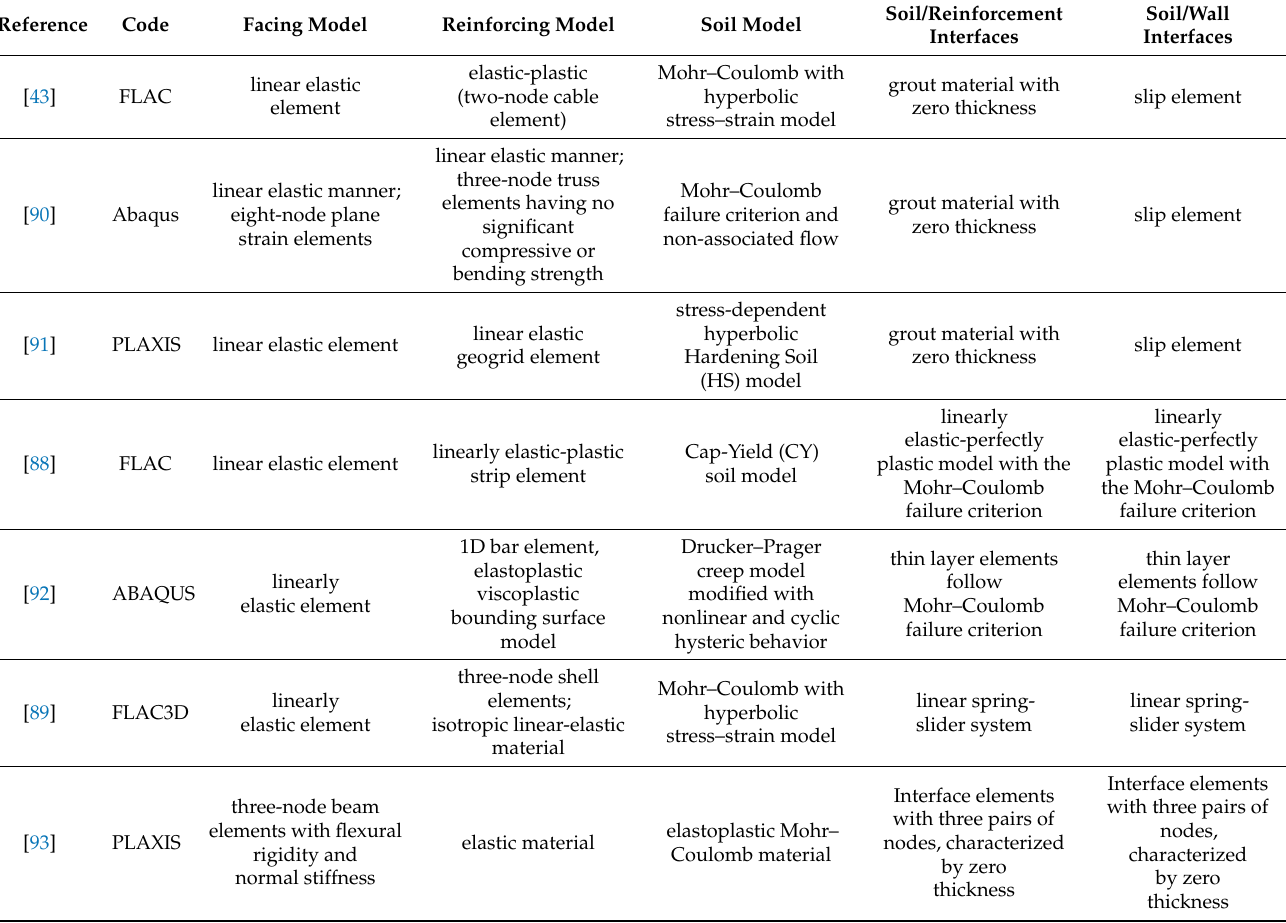
Table 2. Typical assumptions in the numerical modeling of the behavior of RS